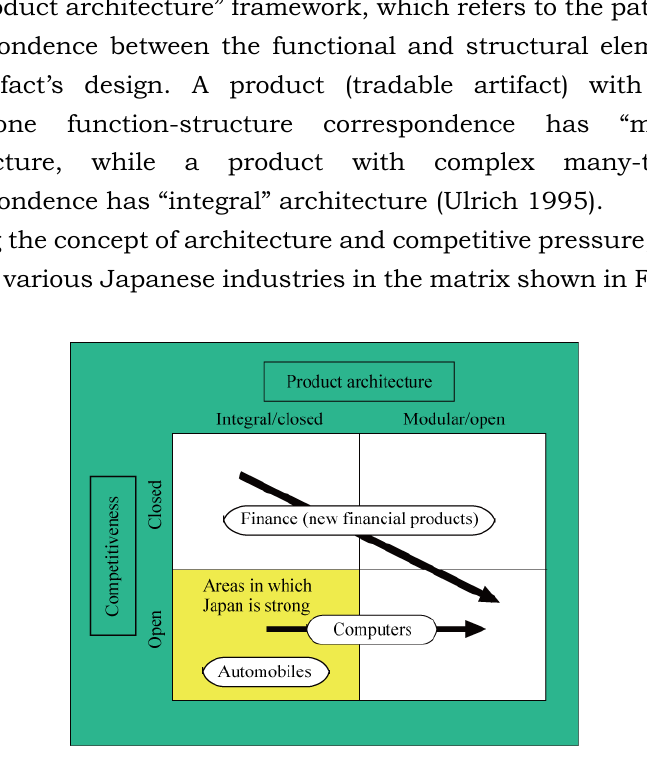
Figure 1. The placement of the automotive